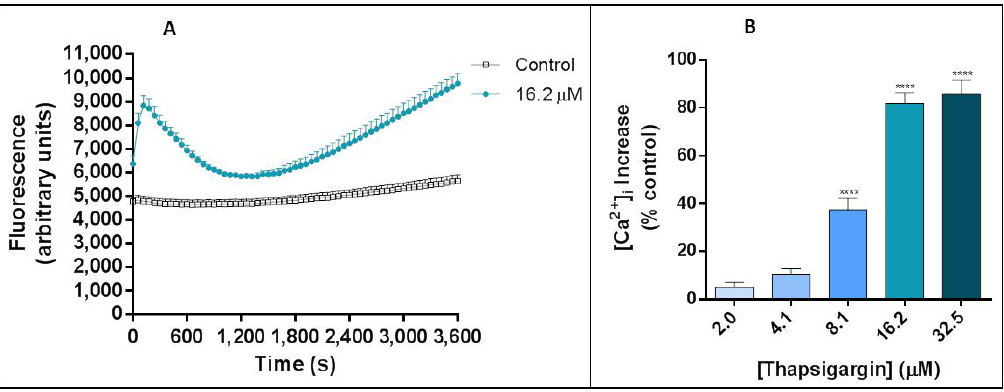
Figure 2. Thapsigargin effects on human neutrophils. ( A ) Thapsigargin (16.2 µ M) effects on human neutrophils intracellular free Ca 2+ concentration, during 1 h. ( B ) Thapsigargin (2.0–32.5 µ M)-induced increase of intracellular free Ca 2+ concentration in human neutrophils, after 1 h of incubation. The values are given as the mean ± SEM ( n ≥ 3). **** p ≤ 0.001, compared with the control assay (without